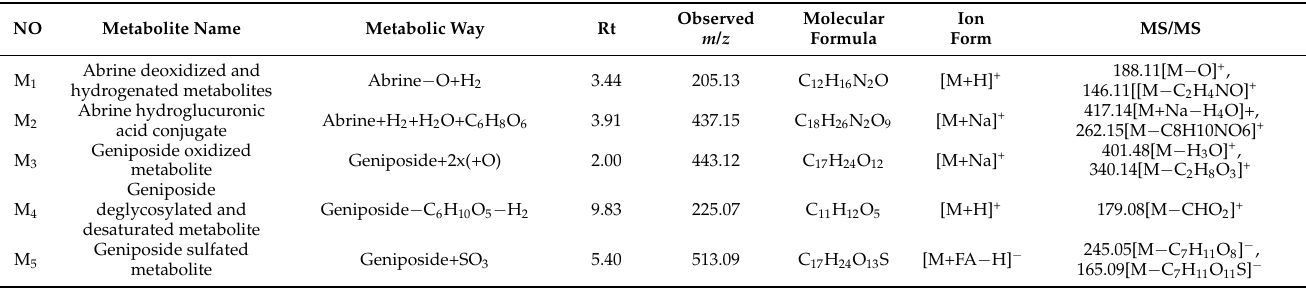
Figure 7. MS/MS information and the cleavage pathway of metabolite M 21 from ginsenoside Rg 1 . A total of 33 metabolites were characterized and identified (Table 2), and they were derived from 12 prototype components, including abrine and afrormosin from Abrus cantoniensis Hance, scoparone and capillarisin from Artemisia capillaris Thunb, geniposide from Gardenia jasminoides Ellis, ginsenoside Rb 1 , ginsenoside Rg 1 , ginsenoside Rd and notoginsenoside T 5 from Panax notoginseng (Burk.) F.H.Chen, cholic acid from Bovis calculus Artifactus, CDCA from Sus scrofadomestica Brisson, and the common component of hyodeoxycholic acid (HDCA) from Bovis calculus Artifactus and Sus scrofadomestica Brisson. After consulting the literature, it is found that nine components, including abrine, scoparone, capillarisin, geniposide, ginsenoside Rb 1 , ginsenoside Rg 1 , ginsenoside Rd, CDCA and HDCA, have significant activities of protecting the liver. They are also the material basis for the efficacy of JGCC in treating DHJS. Table 2. The metabolites of JGCC found in the blood.